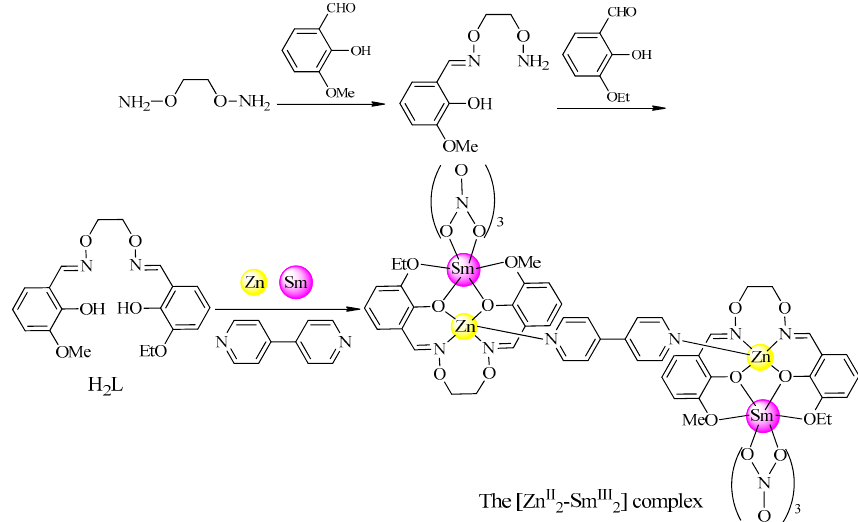
Table 1. CCDC: 1959376. Table 1. Crystal data and refinement parameters for the [Zn II2 –Sm III2 ] complex.